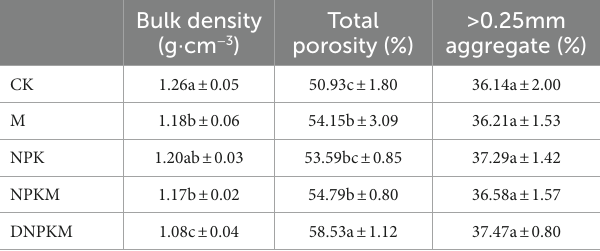
TABLE 2 Soil physical properties of different fertilizer